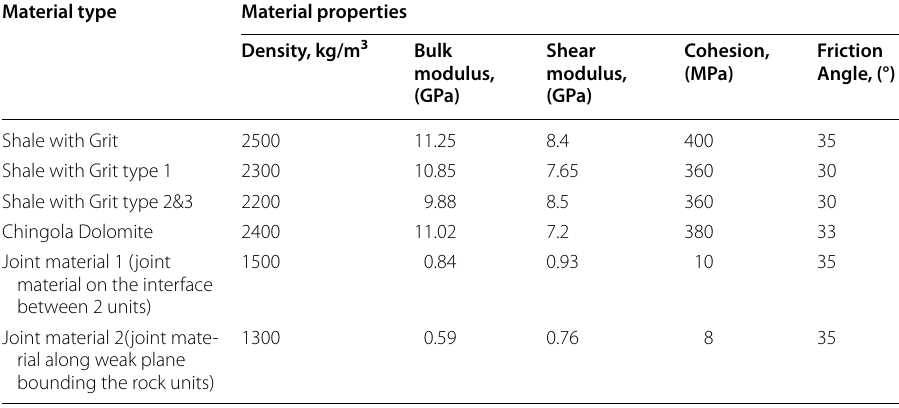
Table 2 Parameters of rock mass and